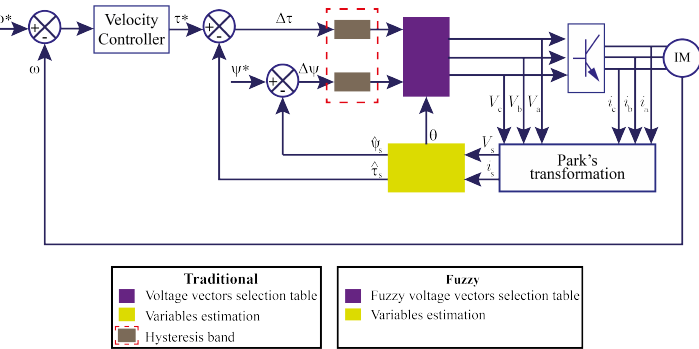
Figure 4. Block diagram of traditional and fuzzy